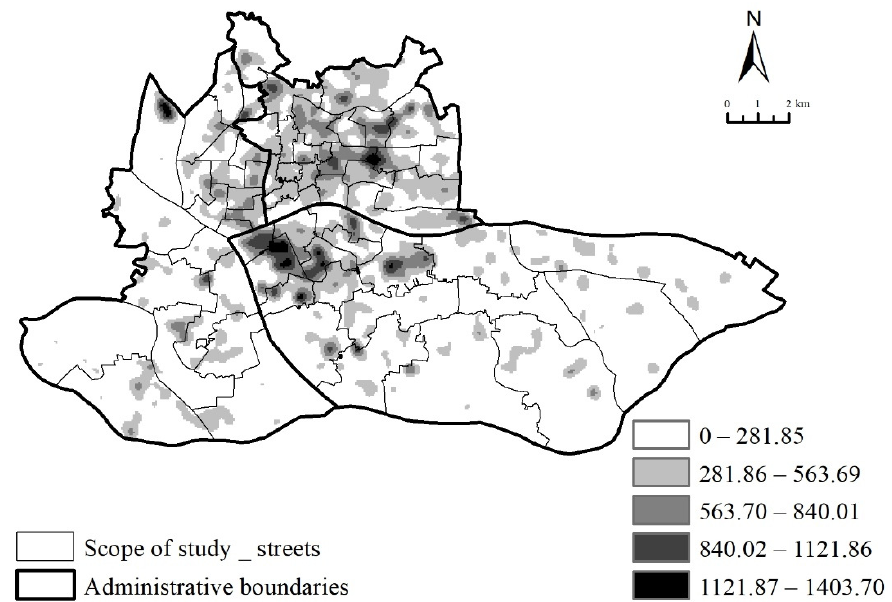
Figure 8. Spatial Distribution of Kernel Density of Street Space Quality. Note: Kernel density calculates the density of point features around each output raster cell.